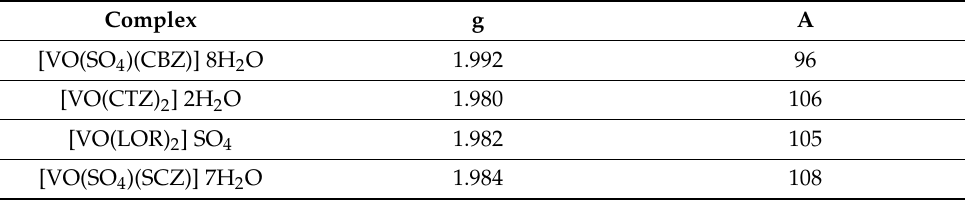
Table 4. EPR parameter in DMF at room temperature of oxidovanadium(IV)